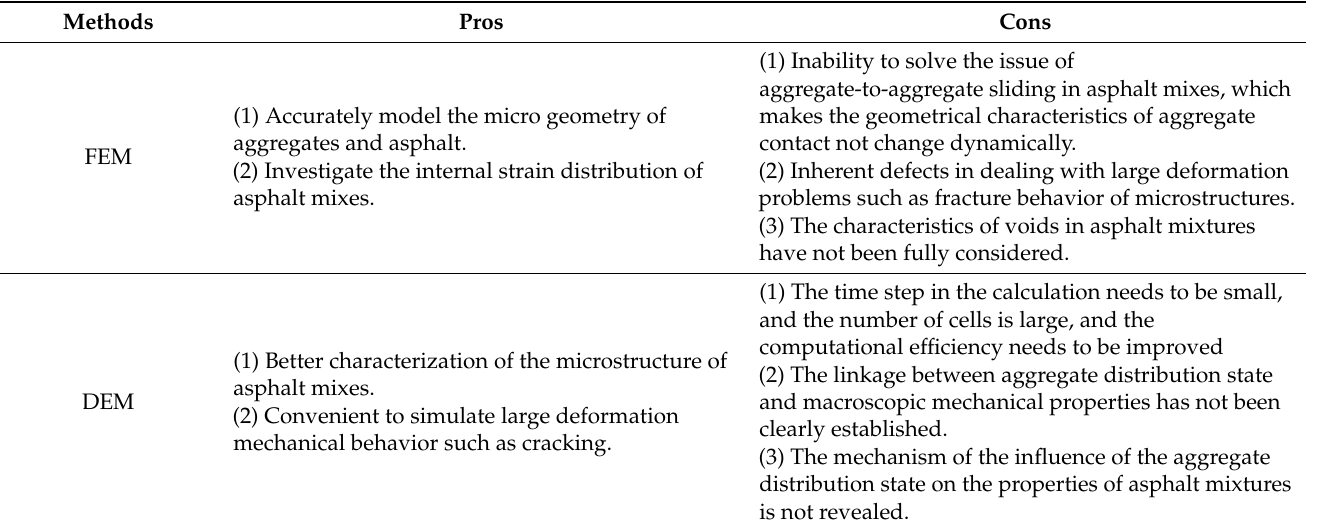
Table 7. Pros and cons of FEM and